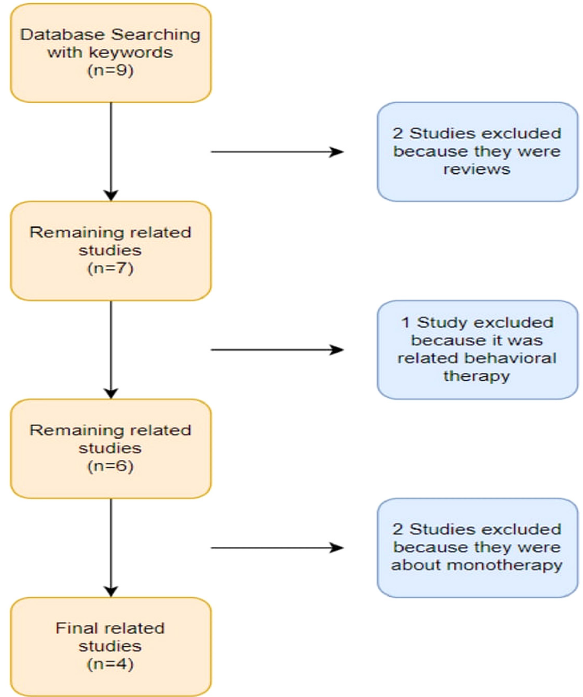
Figure 1. Study design.